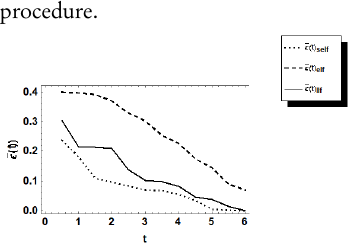
Figure 4 – When c = 2 and h = 2, the MSE of (cid:69) ( t ) using important sampling